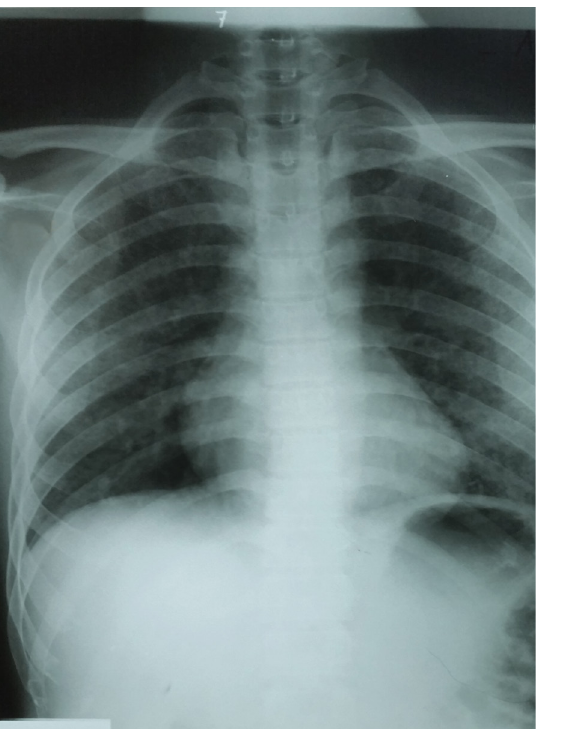
Figure 2. Patient’s repeat chest X-ray (PA view) 2 days after IV methylprednisolone therapy, showing marked reduction in airspace nodular opacities and